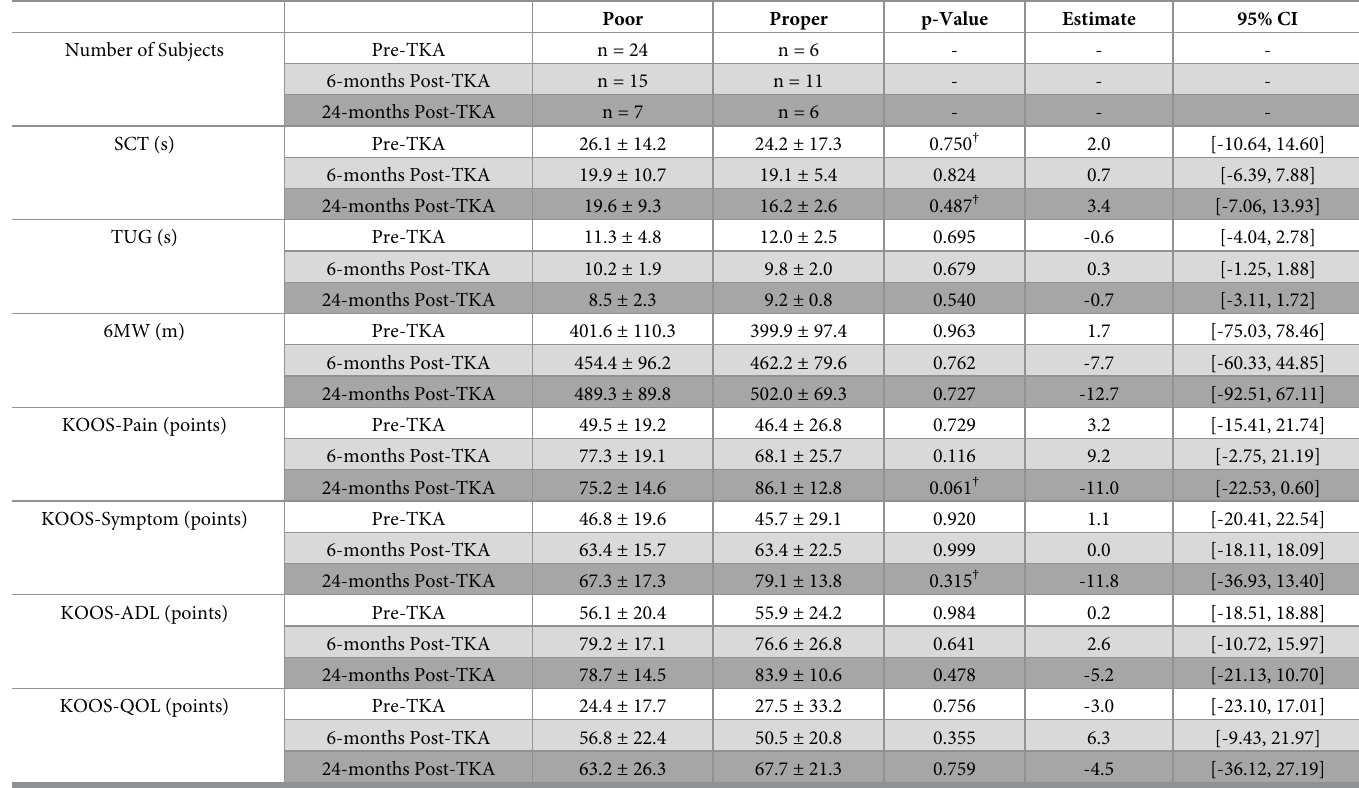
Table 3. Functional measures within module organization groups.